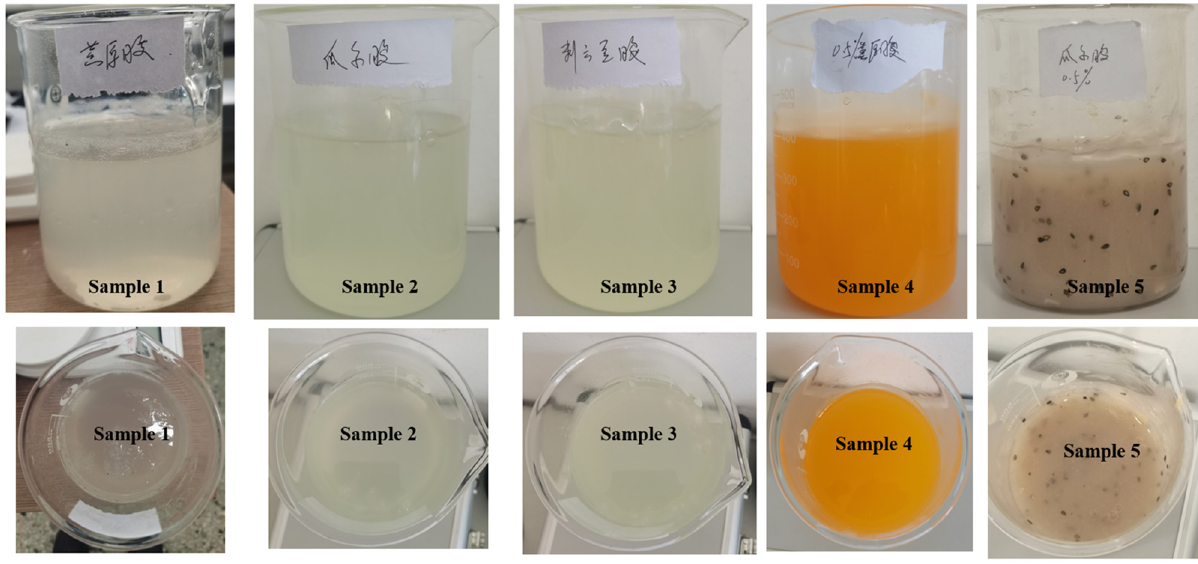
Figure 2: Some experimental samples of food thickening